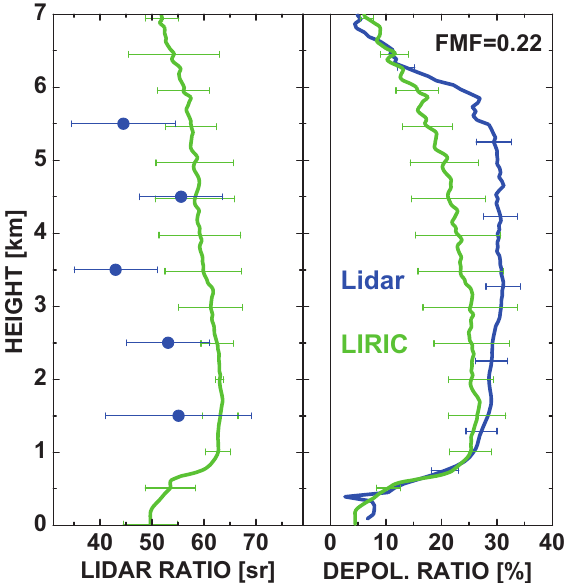
Fig. 6. Particle lidar ratio at 532nm (blue circles) and particle de- Fig. 4. Comparison of LIRIC– and POLIPHON–derived parti- polarization ratio at 532nm (blue curve) observed on 29 May 2008 with Raman lidar and derived by using the LIRIC profiles in Fig. 3 cle backscatter coefficients observed on 29 May 2008. The blue (green curves). Raman lidar signals are smoothed with window POLIPHON curves are taken from Figure 2 of Ansmann et al. lengths of about 1000m in the case of the lidar ratio (blue symbols). Errors bars indicate the uncertainties (one standard deviation). The depolarization ratio profile is given with 60m resolution.